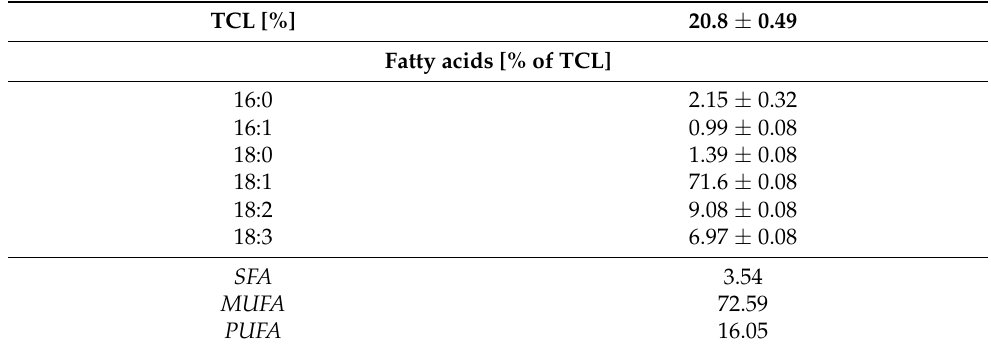
Table 4. Composition of fatty acids of Y. lipolytica 1.31.GUT1/6.CIT1/3.E34672 biomass after cultiva- tion on mixed (glycerol–oil) medium.